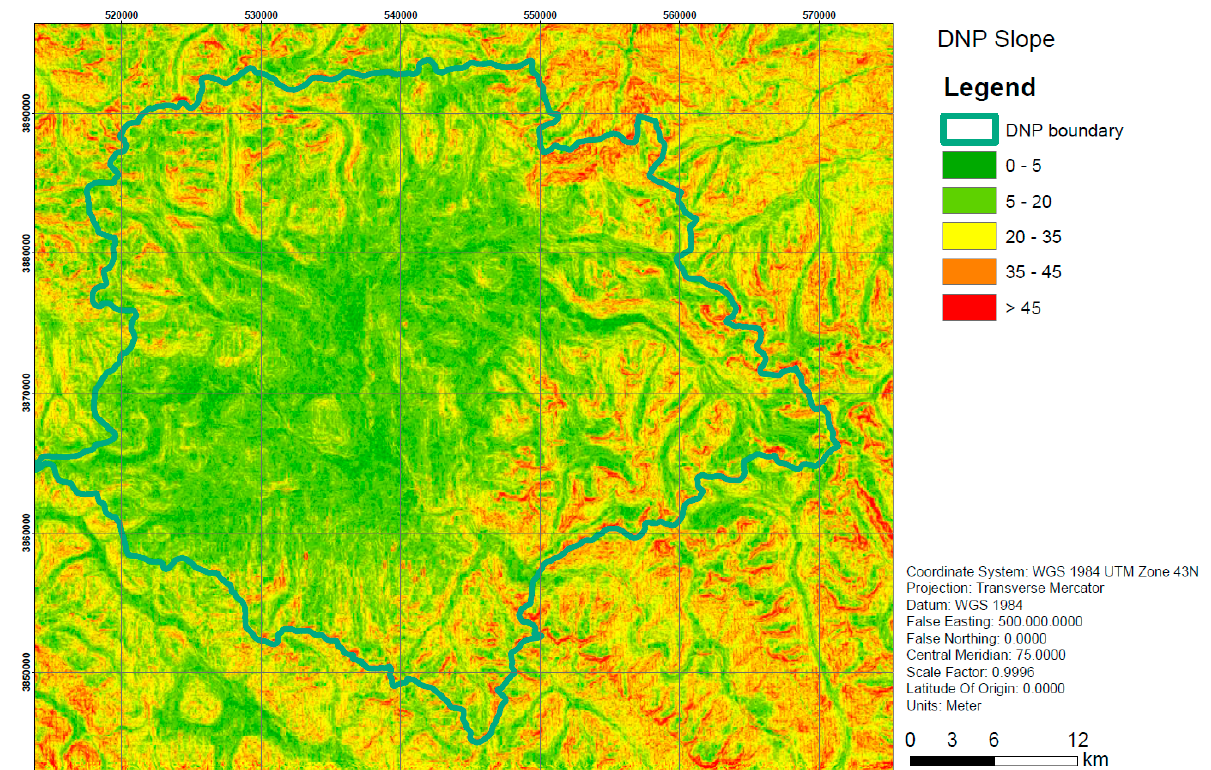
Figure 1. Localization of the Deosai National Park (DNP) in the Deosai Plateau in the Northern Areas region of Pakistan.